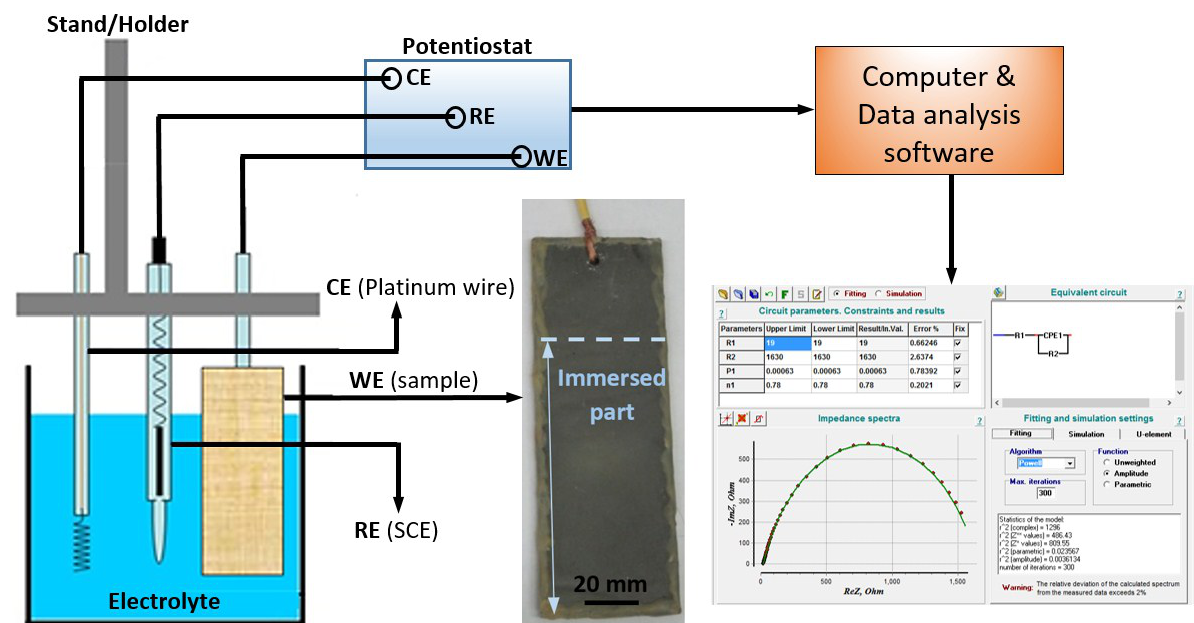
Figure 2. Experimental set up used for electrochemical measurements and data analysis.